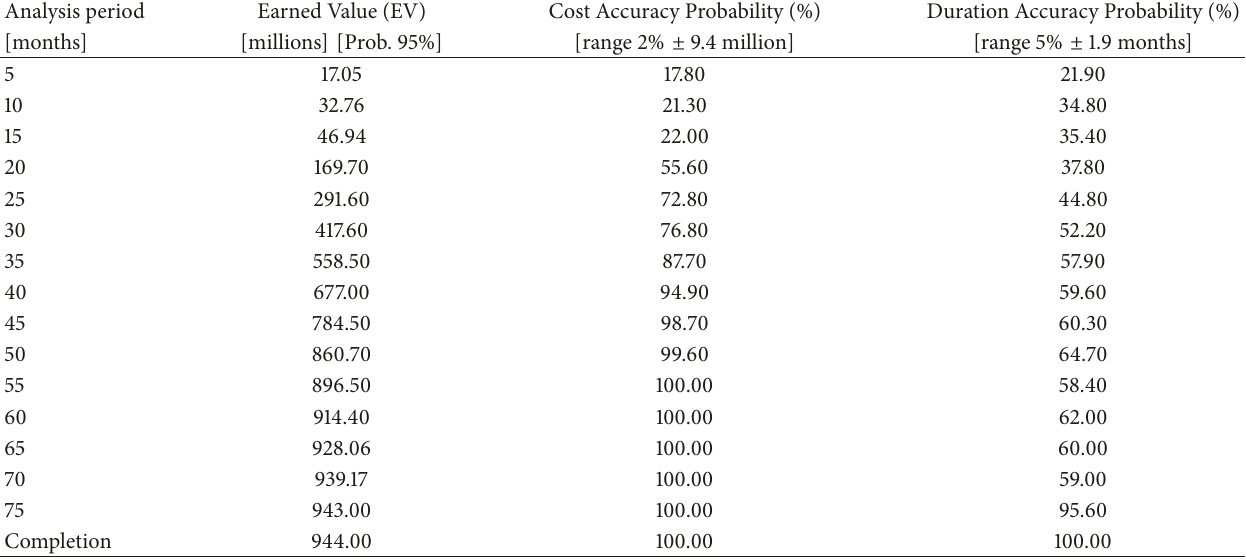
Table 6: Accuracy probability rates in cost forecasts (EVM) and duration forecasts (ES) for the Cardenillo project. Analysis period